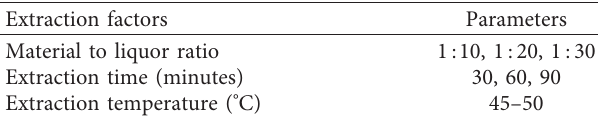
Table 1: Antibacterial agent extraction parameters, water and ethanol used as extraction solvents. Extraction factors